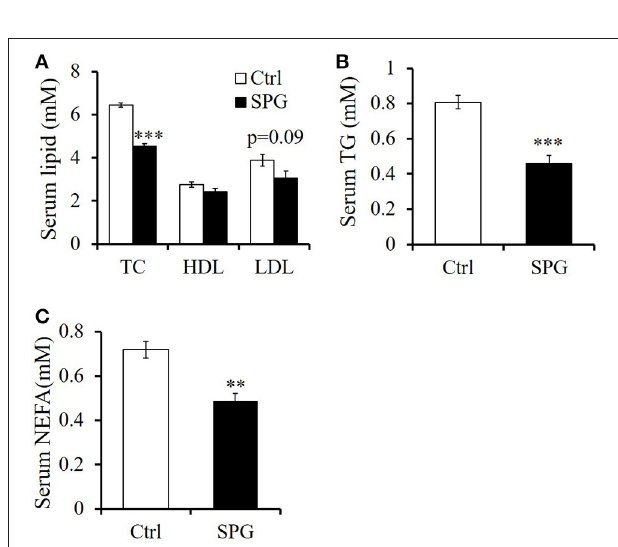
FIGURE 5 | Supaglutide improves lipid profile in the DIO mice. (A) Total cholesterol (TC), high density lipoprotein (HDL), and low-density lipoprotein (LDL). (B) Triglyceride (TG). (C) Nonesterified fatty acids (NEFA). Significant difference between control and SPG is determined using unpaired Student’s t -test. All values are means ± SE ( n = 5 for each group). ** p < 0.01; *** p <